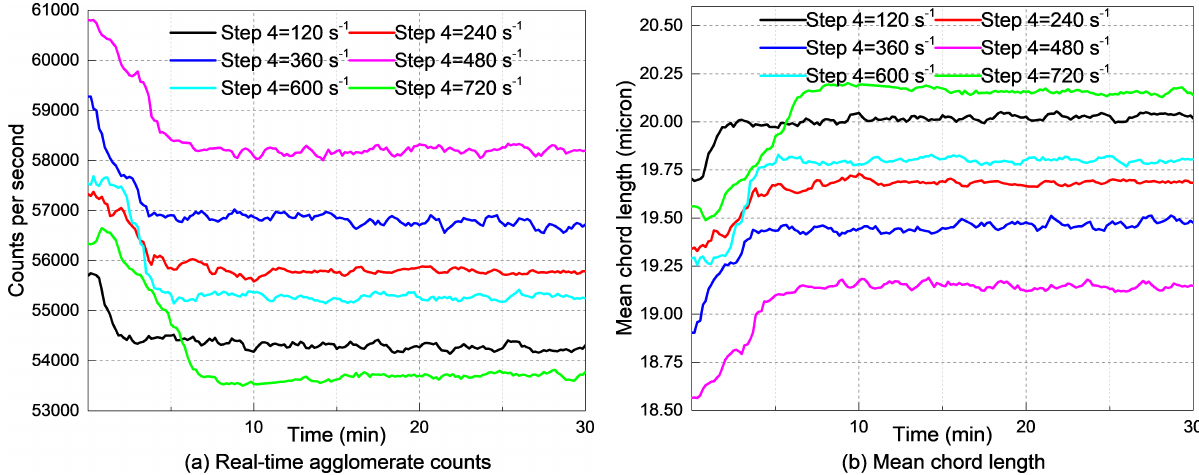
Figure 12: Effect of shear history on fresh state agglomerate condition for CPB-C.